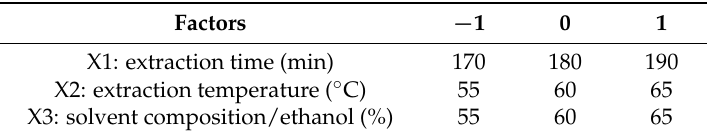
Table 1. Symbols and levels of independent-variables adopted in the developed Box-Behnken Design (BBD) for DHM extraction.